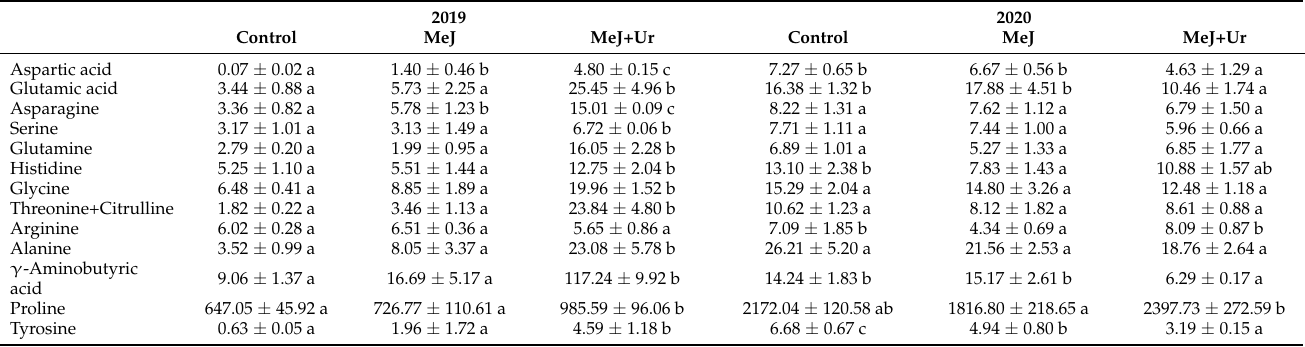
Table 4. Amino acids content (mg/L) in wines from control, methyl jasmonate (MeJ) and MeJ+Urea (MeJ+Ur) treatments, in 2019 and 2020